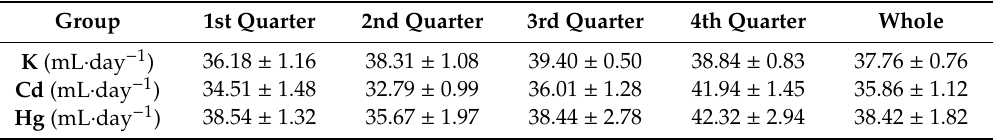
Table 4. Average water intake of male rats ± SD. Table 3. Average water intake of female rats ± SD.